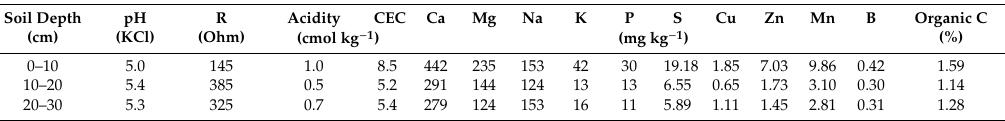
Table 1. Soil physical and chemical property ranges for di ff erent soil depths (cm). Exchangeable base cations (Ca, Mg, K, and Na) and extractable P were determined in a citric acid solution [32]. Soil Depth